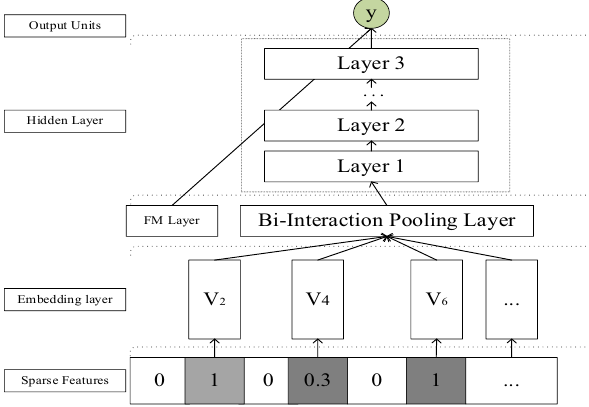
Fig. 4 Network topology of DeepFM